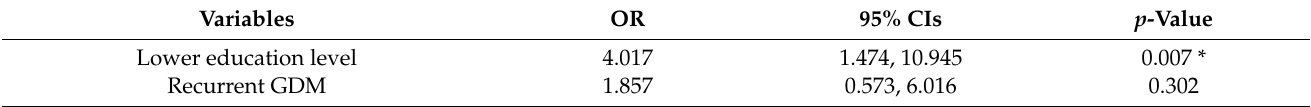
Table 4. Odds ratio and 95% confidence intervals for factors associated with metabolic